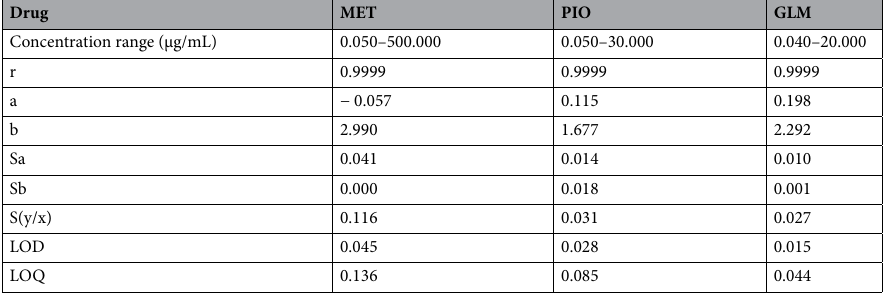
Table 3. Regression parameters for estimation of MET, PIO and GLM in pure and tablet form using the developed method. r: correlation coefficient; b: slope; a: intercept; S b : standard deviation of slope; S a : standard deviation of intercept; S y/x : residual standard deviation; LOQ: limit of quantitation; LOD: limit of